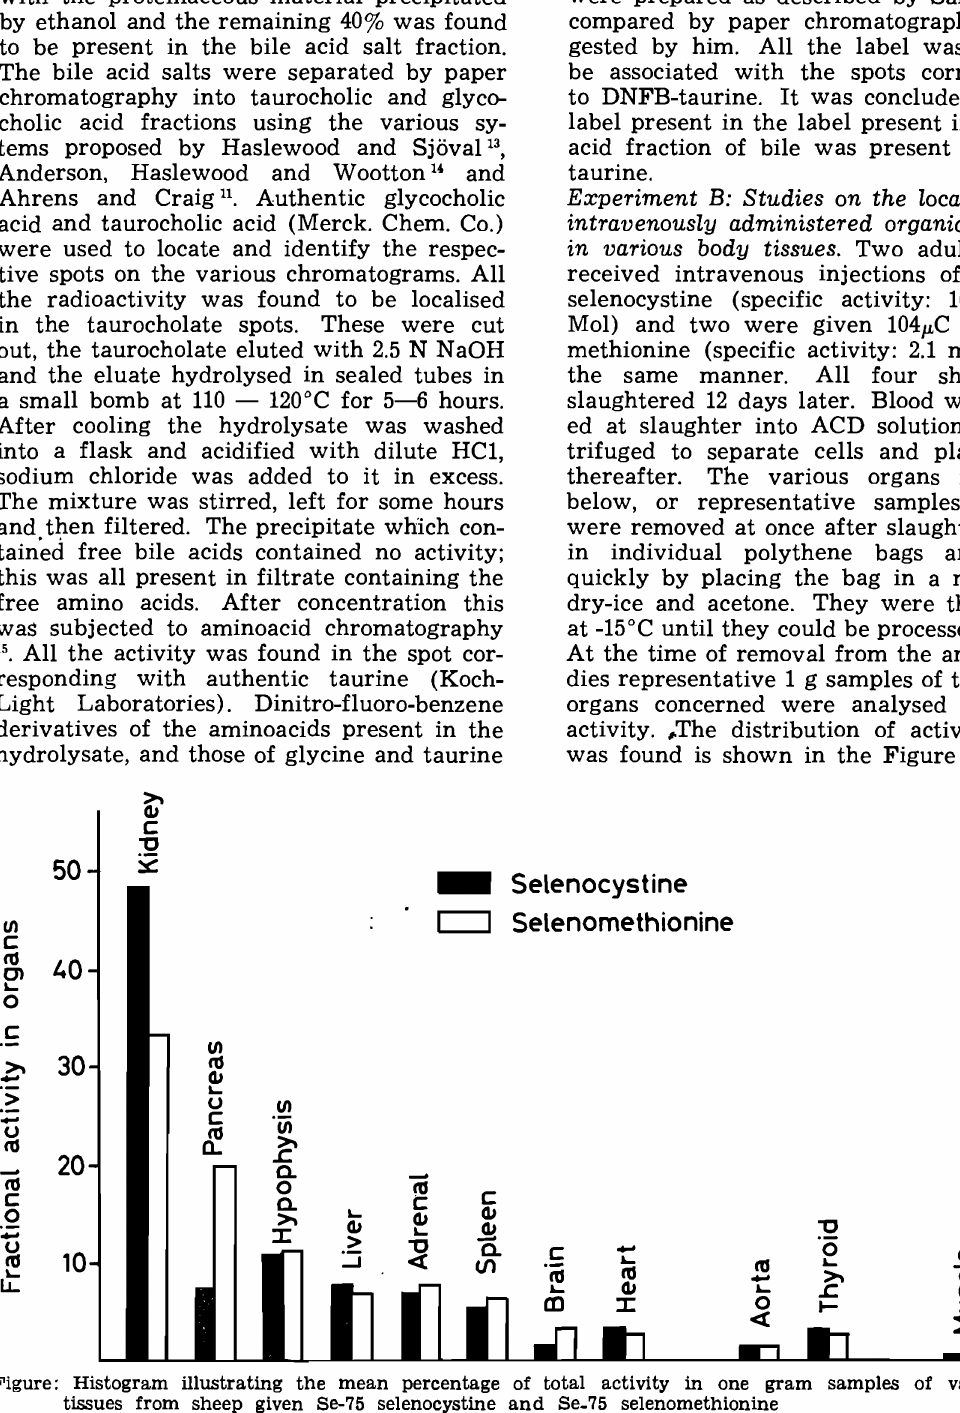
Figure: Histogram illustrating the mean percentage of total activity in one gram samples of various body tissues from sheep given Se-75 selenocystine and Se_ 75 selenomethionine